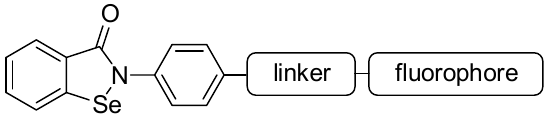
Figure 1. Structure of the fluorescently labeled ebselen derivatives.